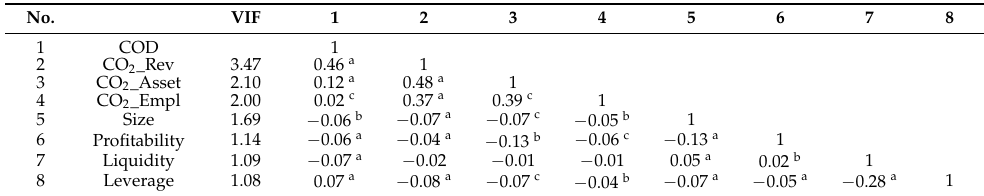
Table 3. Pearson’s correlation